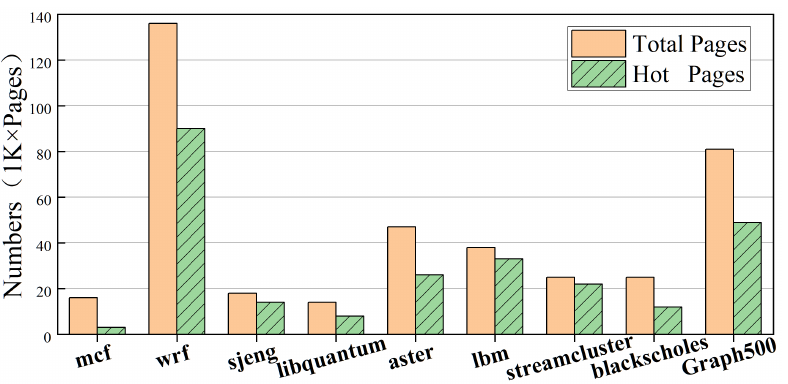
Figure 7. Numbers of total accessed pages and hot pages.